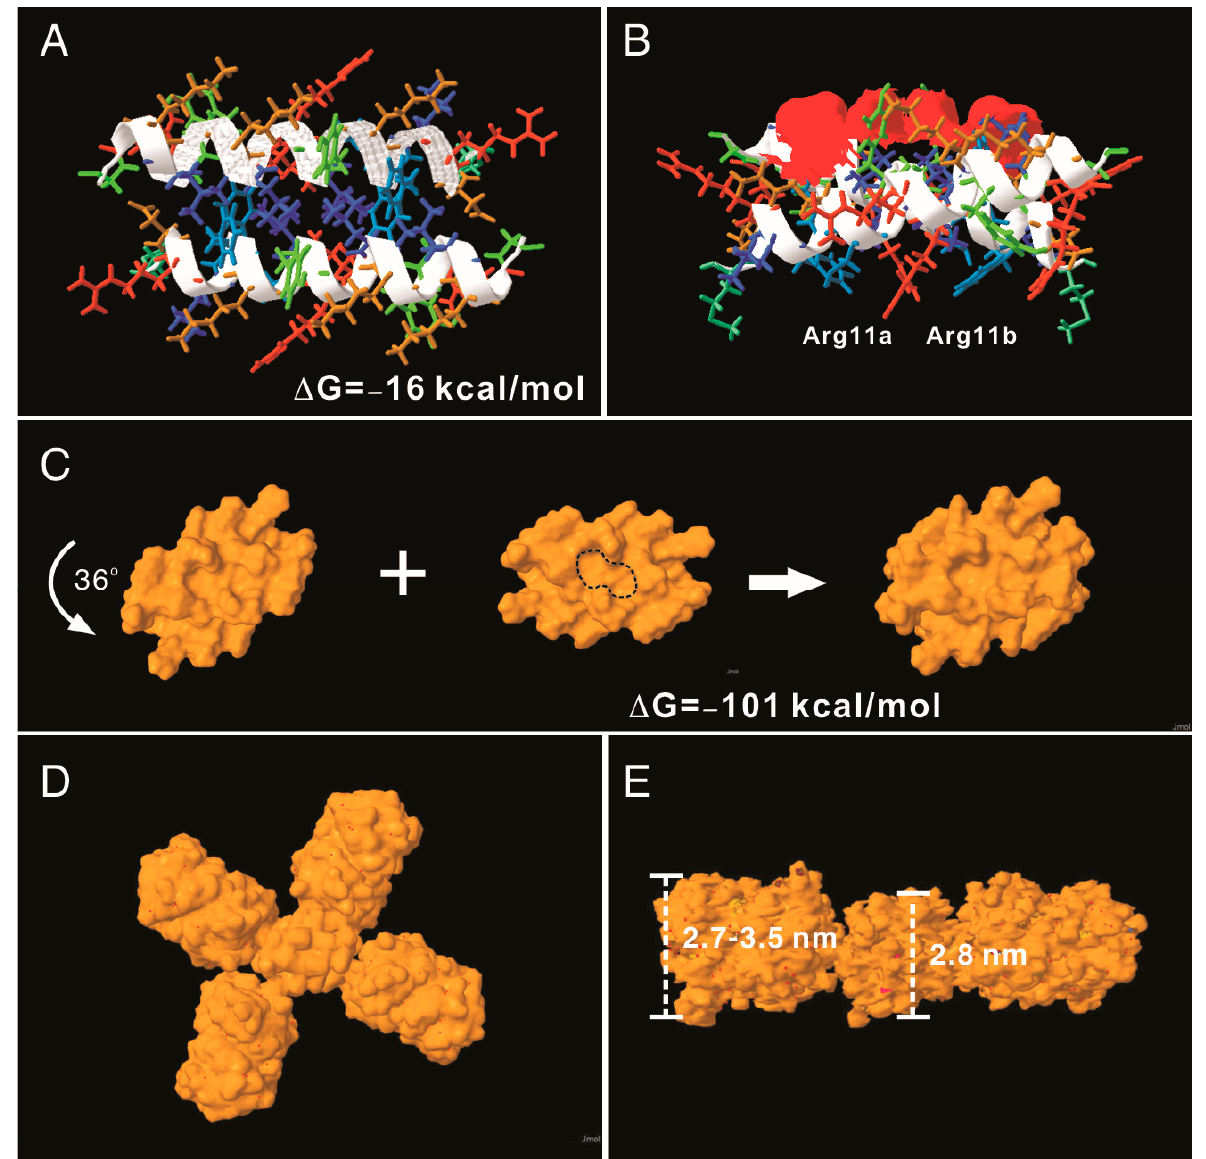
Figure 2. AH3–GFP protein nanoparticle structural modeling. ( A ) The assembling unit of AH3–GFP protein nanoparticles was modeled as a dimer interacting through hydrophobic interaction using AscalaphDesigner. Amino acid side chains are colored according to their hydrophobicity using SPDB v4.10. The most hydrophilic side chains are colored red, and the most hydrophobic side chains are colored blue. Side chains with hydrophobicity in between are colored transitionally. The two α -helix backbones are marked by a white ribbon. The intermolecular interaction force ( ∆ G) is shown in the bottom-right corner. ( B ) The bottom view of the AH3 dimer shows the location of the hydrophobic patch (marked by a red surface). The anti-parallel alpha helix fromed by two monomers forms a cross and has an angle of 24 degrees. ( C ) The water-accessible surface of the AH3 dimer is modeled using Jmol, and the stacking of the second dimer onto the first one is achieved after turning the second dimer counter clockwise by 36 ◦ . The two hydrophobic pockets are enclosed in a dashed line. The intermolecular force ( ∆ G) between two dimers is shown. ( D ) The AH3 tetramer with four fused GFP molecules is modeled to form a cross shape. ( E ) The front view of the AH3–GFP tetramer is shown with two GFP molecules removed for a clear view. The distance between two repeating atoms of the stacked tetramer is measured and shown as the thickness of the AH3 tetramer, and the thickness of the GFP monomer is measured as the distance across the protein barrel